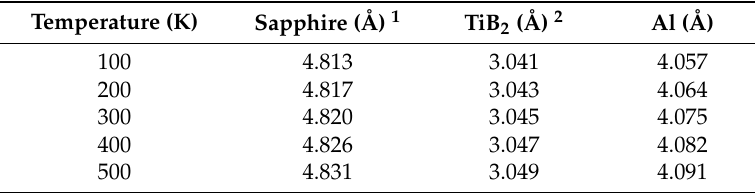
Figure 7. Temperature influence on the mismatches of the (0001) sapphire– (111) Al and the (0001) TiB 2 – (111) Al interfaces.